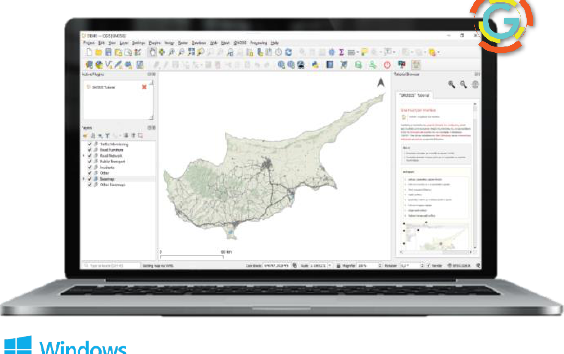
Figure 5. Desktop User Interface.